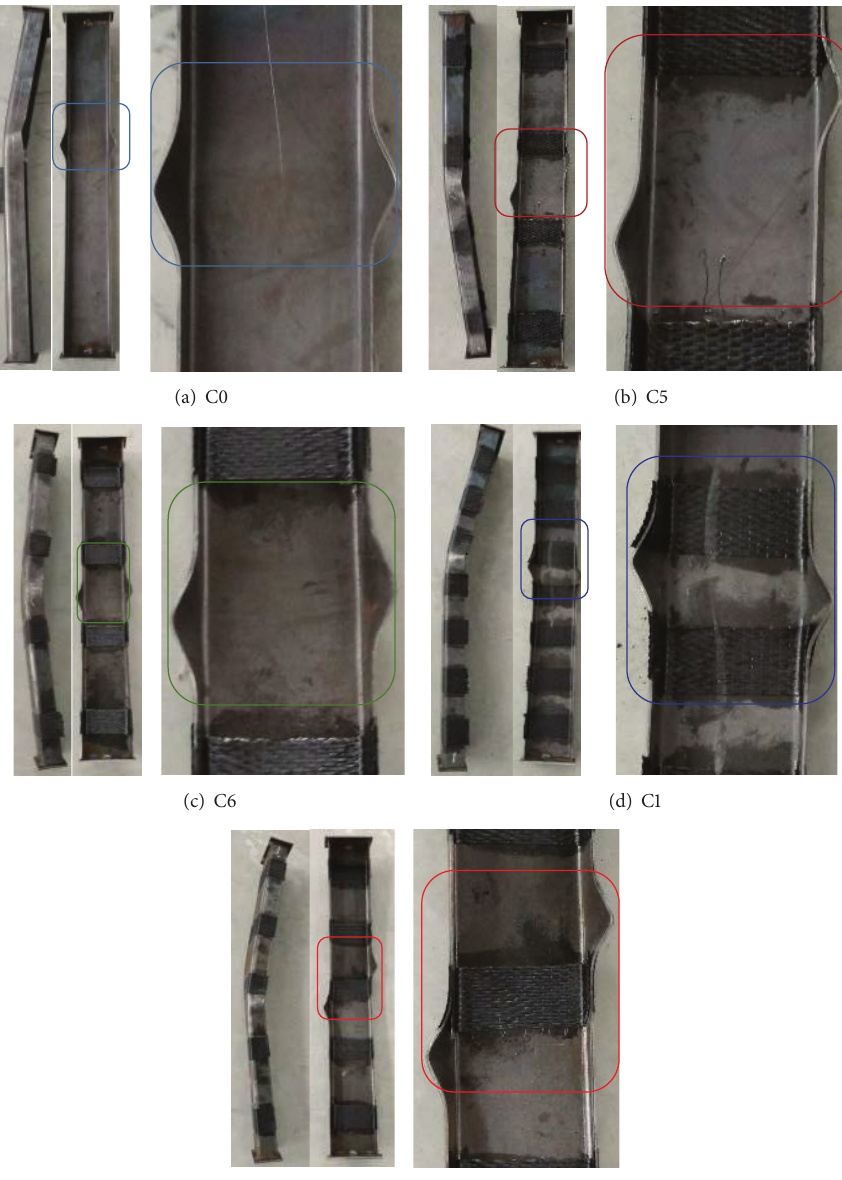
Figure 4: Failure modes of specimens exhibiting flange local